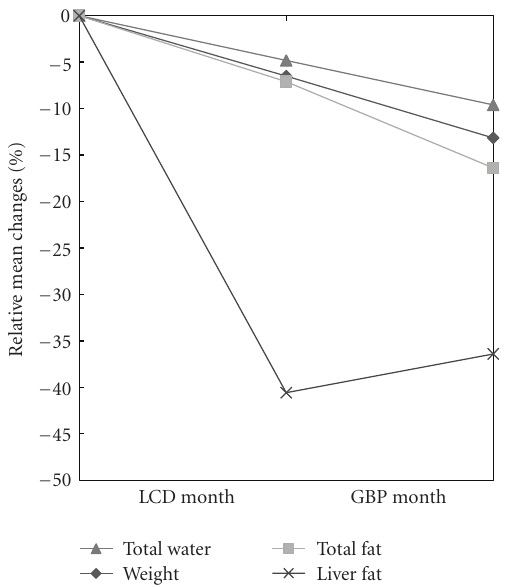
Figure 2: Relative mean changes of weight, total fat, total water, and liver fat during the LCD and the GBP months ( n = 13).